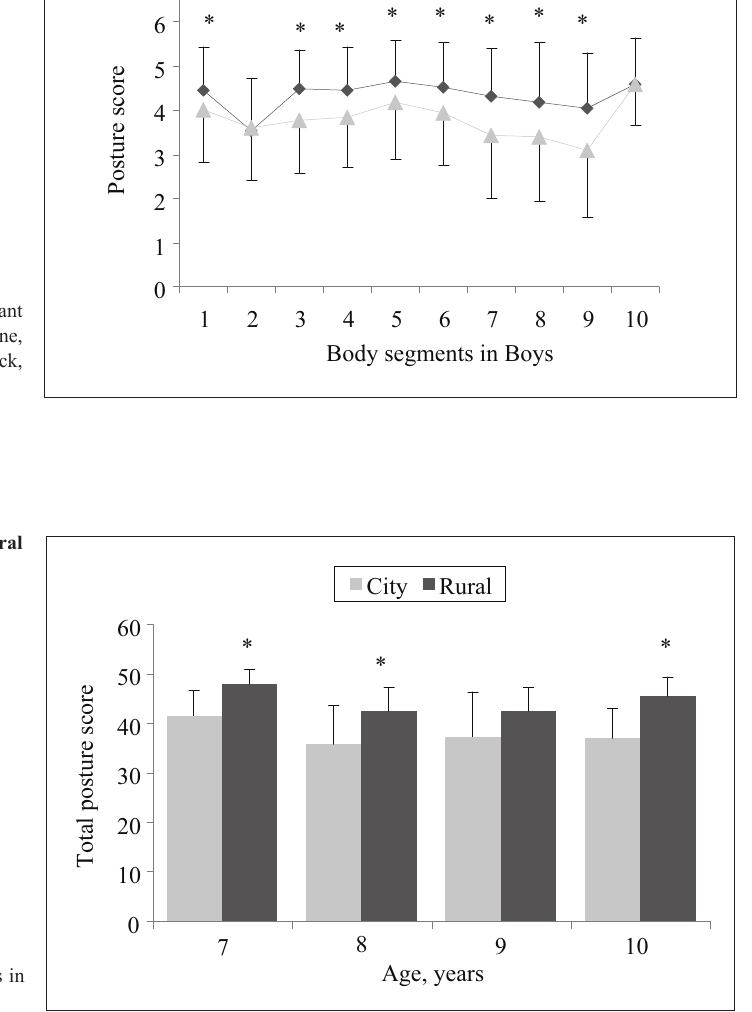
Figure 4. Total posture score in city and rural children aged 7 to 10